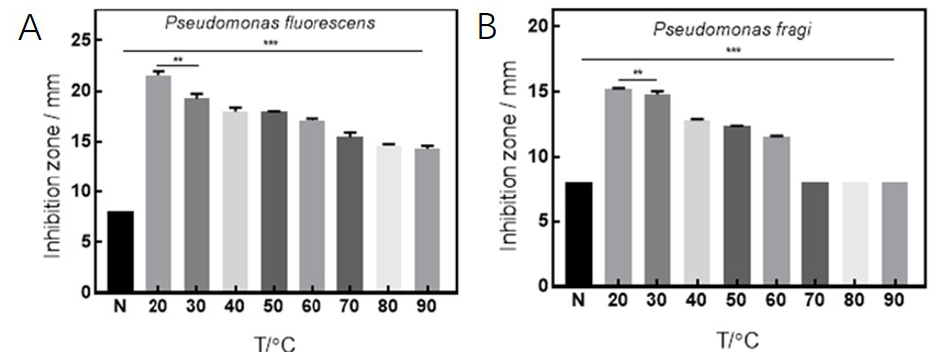
Figure 3. Antibacterial effects of D. algida via the treatment at different temperatures against the target Pseudomonas , where ( A , B ) are P. fluorescens and P. fragi , respectively. The data are shown as